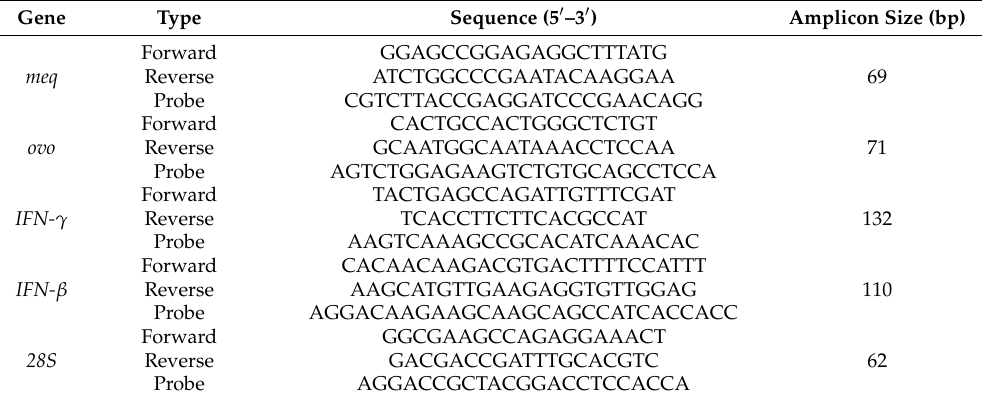
Table 2. Primer and probe sequences used for quantitative real-time polymerase chain